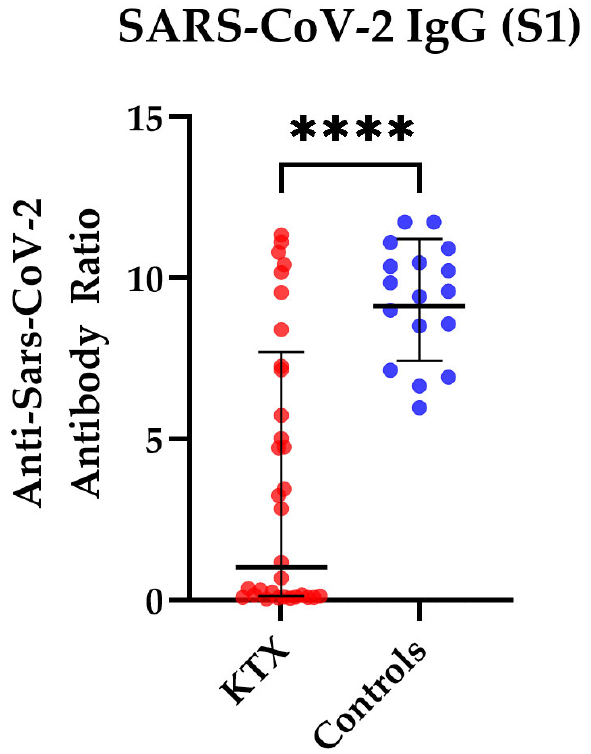
Figure 5. SARS-CoV-2-specific IgG antibody responses in kidney transplant (KTX) patients and healthy controls. SARS-CoV-2-specific IgG antibody responses are shown as antibody ratios, which determines a quotient of antibodies in the patient samples and in a control sample. Red circles show data of the KTX patients, while blue circles indicate the data of healthy volunteers. Two-tailed Mann–Whitney tests were used to compare the responses (**** p < 0.0001). Mean values are represented by horizontal lines, while the standard deviation is represented by error bars.